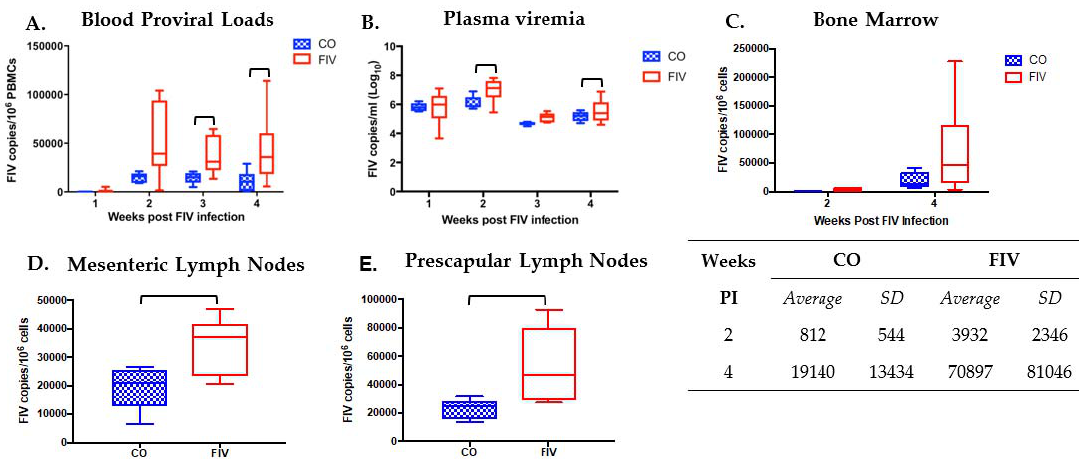
Figure 2. Feline immunodeficiency virus (FIV) proviral loads ( A ) and FIV plasma viremia ( B ) were statistically decreased at various times post FIV infection (FIV PI) in CO versus FIV cats. At 3 ( P = 0.016) and 4 ( P = 0.049) weeks FIV PI for FIV proviral loads, and at 2 ( P = 0.048) and 4 ( P = 0.011) weeks FIV PI for plasma viremia. However, no statistical differences were found by group and time ( P = 0.190). Bone marrow proviral loads ( C ) were not statistically different by group and time ( P = 0.182), but a trending difference was noted between CO and FIV cats at 2 weeks FIV PI ( P = 0.084) and no difference was found at 4 weeks FIV PI ( P = 0.196). Proviral loads in mesenteric ( P = 0.0367) ( D ) and prescapular ( P = 0.0152) ( E ) lymph nodes were lower in the CO as compared with FIV cats at 4 weeks FIV PI. Bars indicate statistical differences ( P <0.05) between groups.